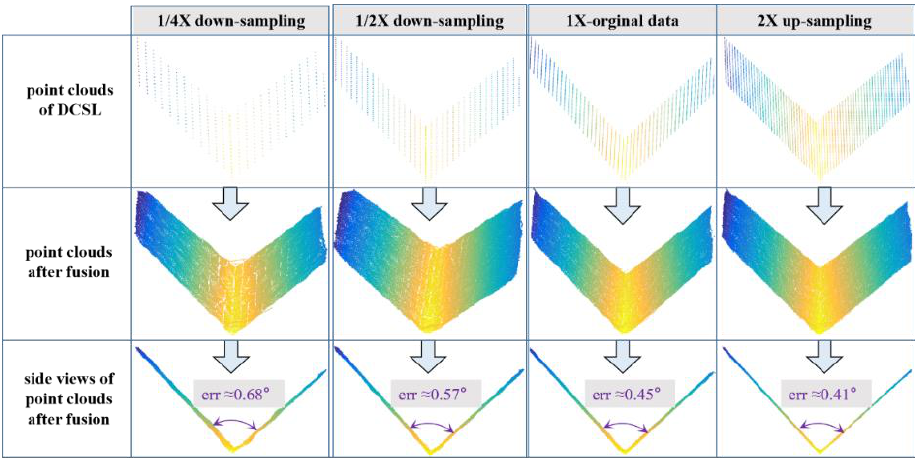
Figure 11. Corner reconstruction errors of two perpendicular planes with regard to the sparsity of DCSL’s data.